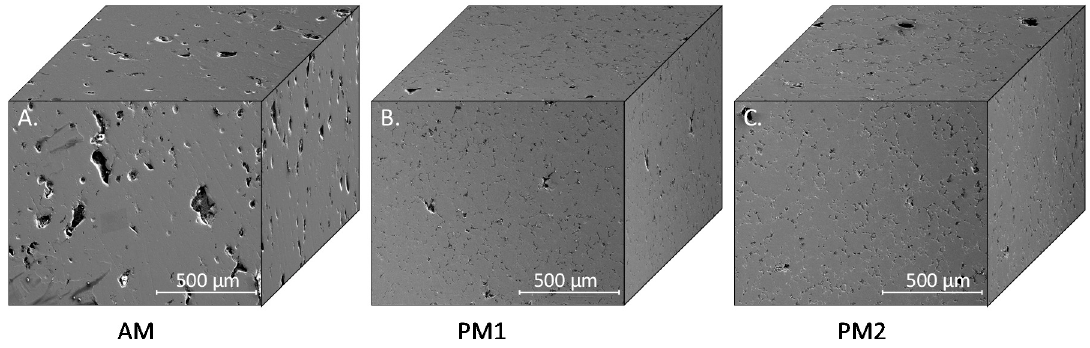
Figure 9. SEM images of internal porosity. ( A ) AM, ( B ) PM1 and ( C ) PM2.